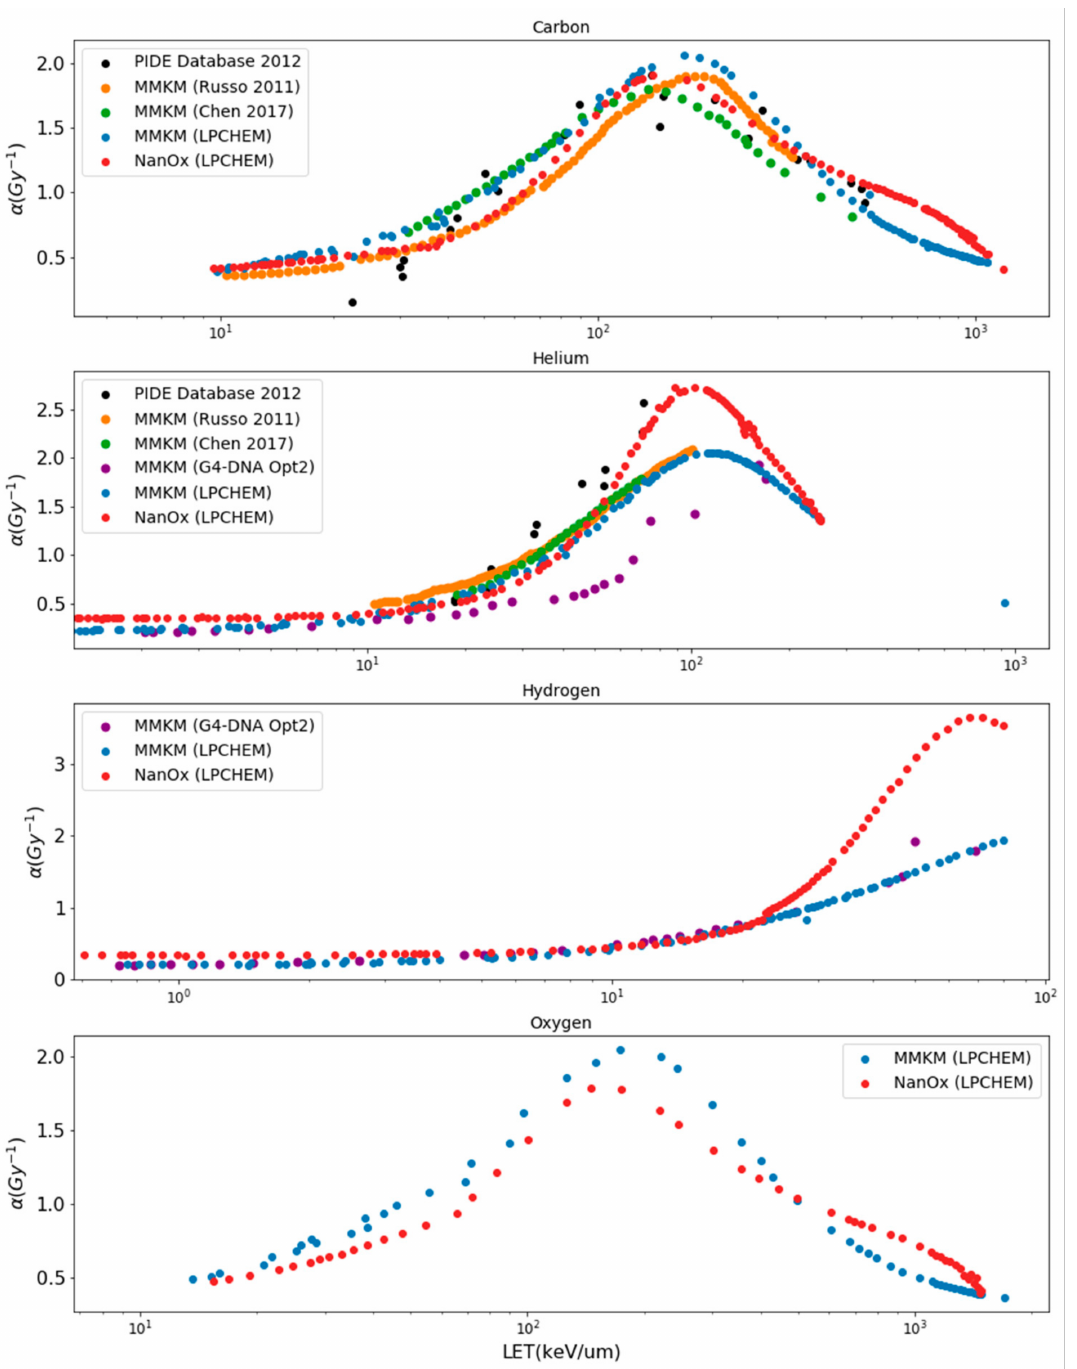
Figure 4. Predictions of α values as a function of LET for the HSG cell line in response to irradiations with carbon, helium, hydrogen, and oxygen monoenergetic ions, for mMKM and NanOx models, using LPCHEM and Geant4-DNA MCTS codes. For carbon and helium ions, our results were compared to Chen et al. [30], Russo et al. [31] and to the PIDE database